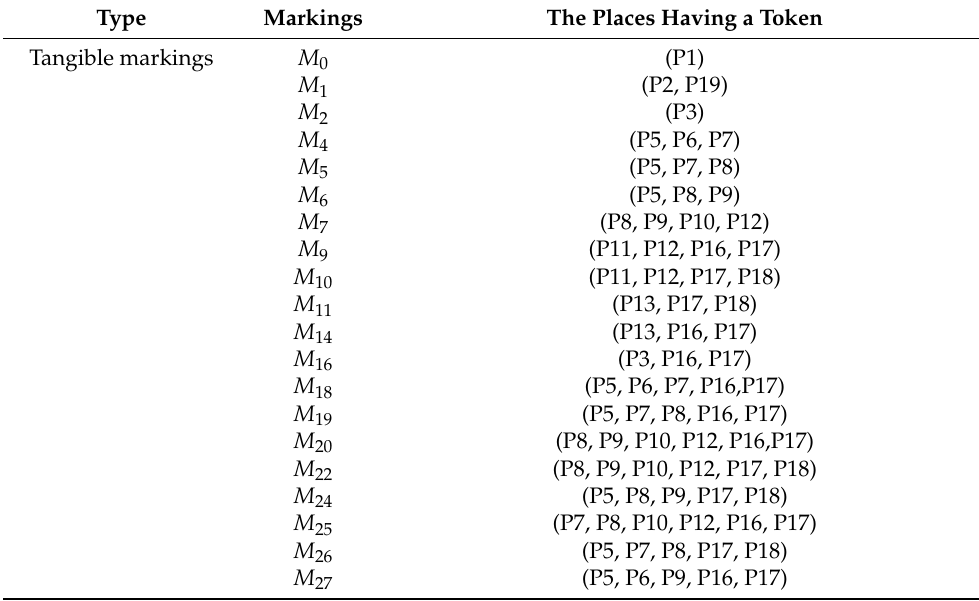
Table 3. The total possible markings of the GSPN model in Figure